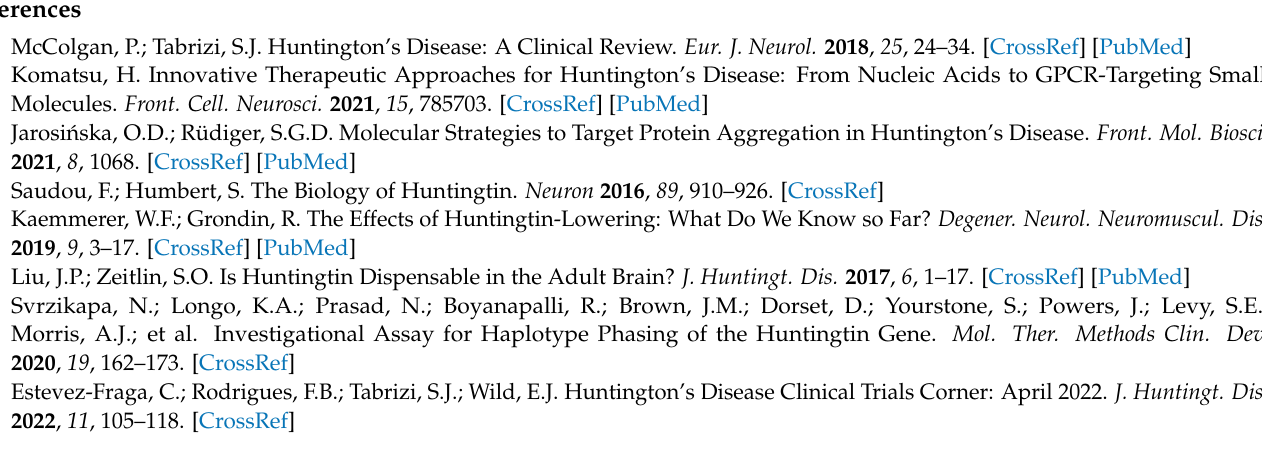
Figure S4: Physicochemical characterization of RVG-targeted cyclodextrins (CD).ASO nanocom- plexes. (A) Representative transmission electron microscopy (TEM) of RVG-targeted and untargeted CD3:ASO nanocomplexes. (B) Particle size and Polydispersity index (PDI) in hCMEC/D3 culture media. (C) Time-dependent particle size and PDI in hCMEC/D3 culture media at 37 ◦ C. Mean ± S.E.M of 6 technical replicates. All at mass ratio 10:1, 750 nM ASO. Scale bars = 100 nm; Figure S5: Effects of RVG-targeted cyclodextrins (CD)s.ASO nanocomplexes on cell viability and TEER. (A) The viability of ST14A cells (1.5 × 10 6 ) and hCMEC/D3 cells (3.0 × 10 4 ) were measured 72 h after treatment with CDs loaded with ASO, weight ratio 10:1, 100 nM per well. Living cells were determined using a CellTiter-FLuor assay and expressed as a % of the control. (B) Transendothelial resistance (TEER) was measured on day 11 (3 days of treatment) using EVOL volt-ohm meter. (C) TEER values are shown as % of control. Mean ± S.E.M of 3 technical replicates performed in triplicate; Figure S6: Viability of HD patient-derived fibroblast cell line GM04723 (CAG15/67) measured 72 h after treatment